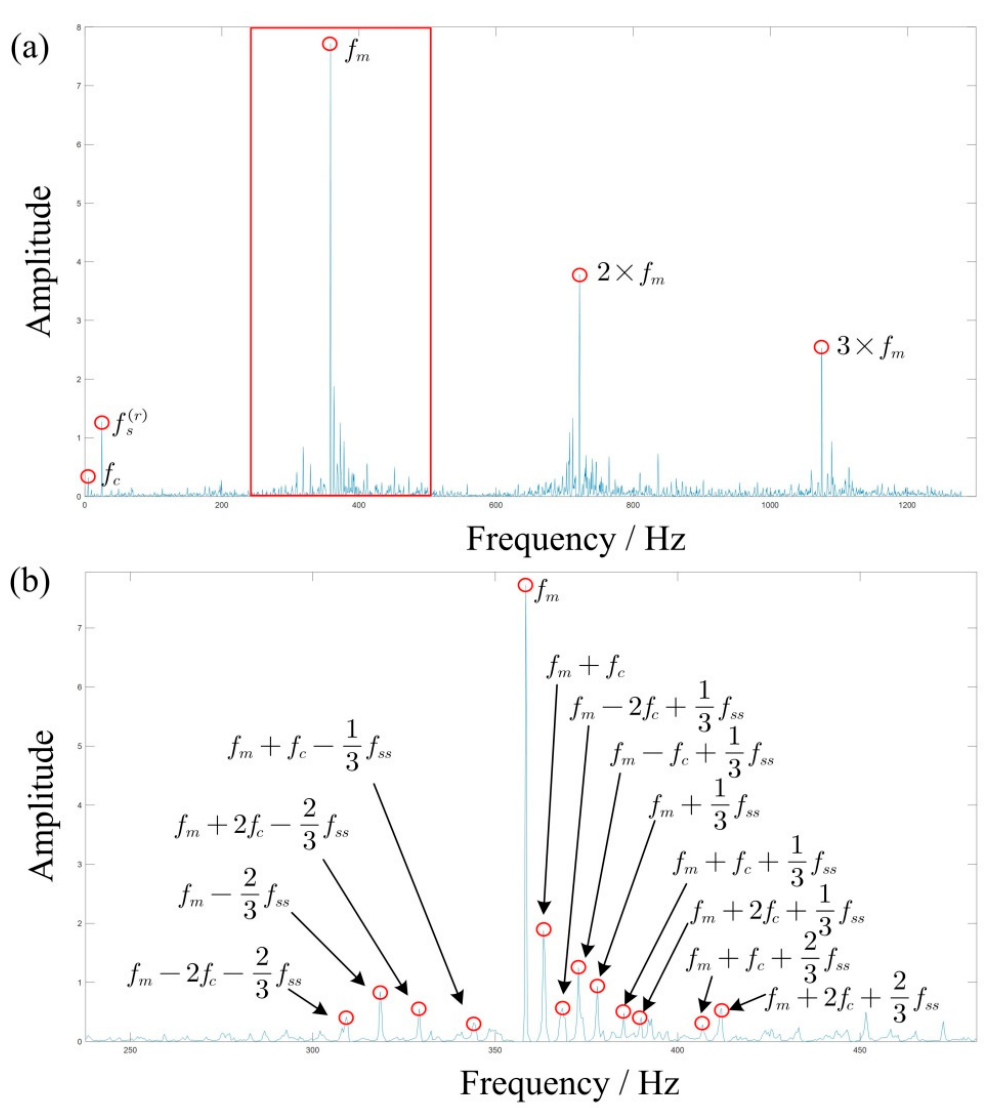
Figure 15. ( a ) 2D energy-frequency map of the vibration signal and ( b ) an enlarged view.